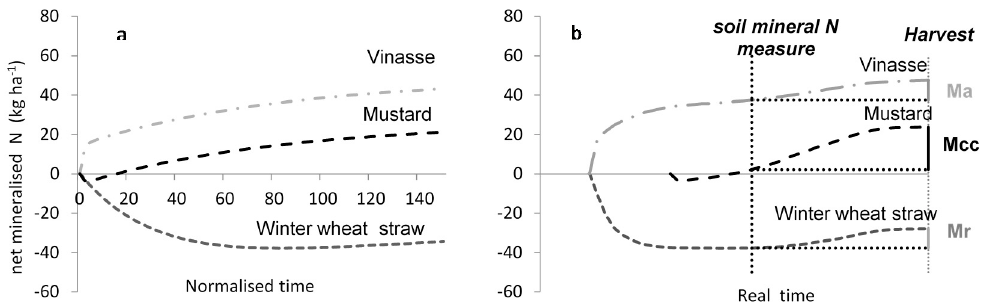
Figure 1. Examples of the net N contribution of organic inputs to soil mineral N. ( a ) Potential net N mineralisation curves for vinasse, mustard residue (catch crop) and winter wheat straw modelled using AzoFert ® (organic product, residue and catch crop catalogues). Net mineralisation is expressed as a function of normalised time (equivalent days at 15 °C and field capacity). ( b ) Calculation of the net contribution of vinasse ( Ma ), mustard residues ( Mcc ) and wheat straw ( Mr ) during plant growth. The net contribution is calculated as the difference between net mineralisation at balance opening and closing. This contribution considers the actual date of the application of the various inputs.